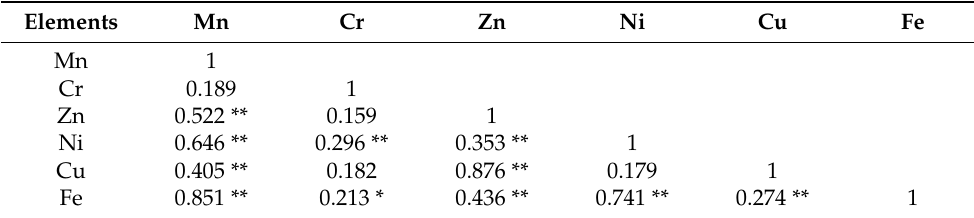
Table 2. Correlation coefficient matrix for soil metal elements.